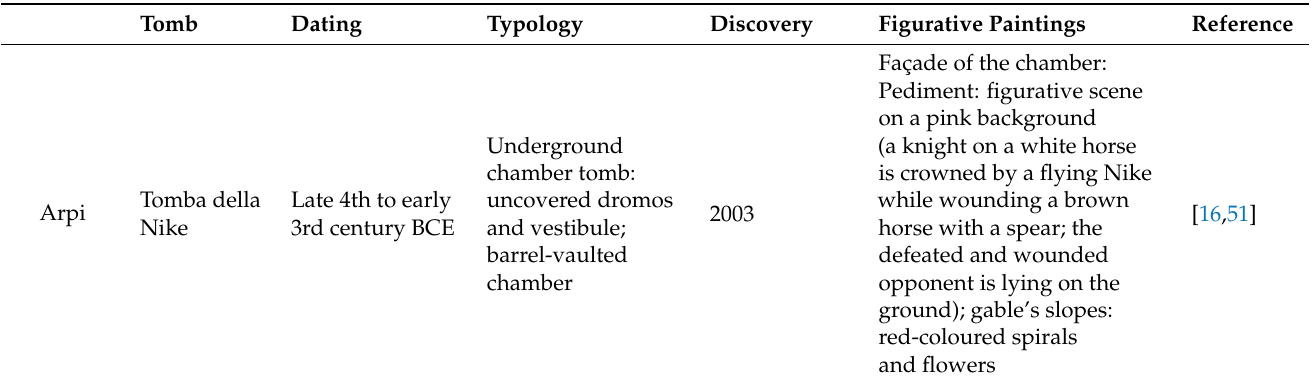
Figure 10. Places mentioned in the text. Table 4. Studied